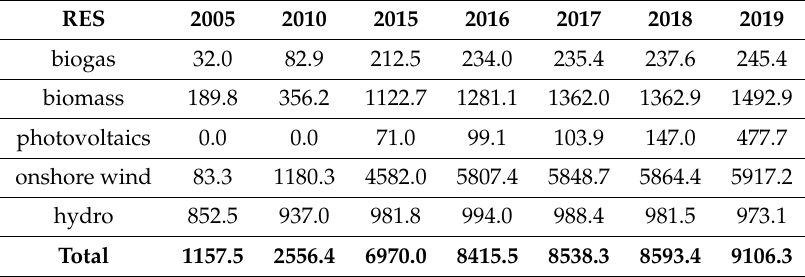
Table 8. RES-E installed capacity in Poland, in (MW) [40].